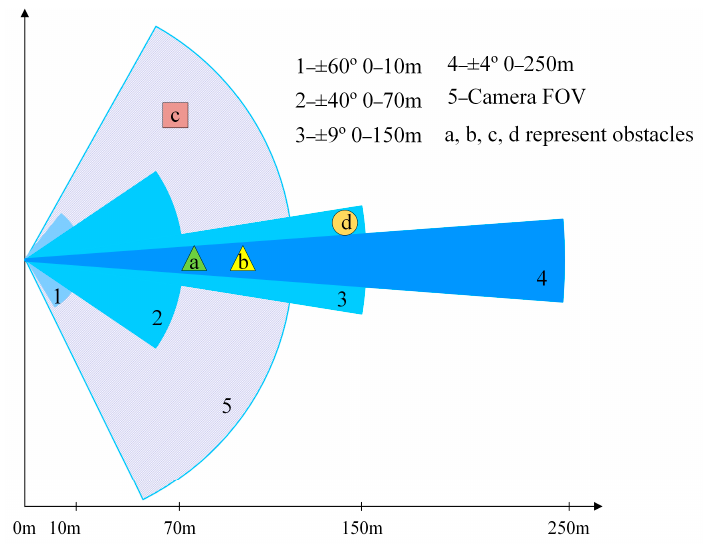
Figure 1. Visual field angle of fusion of single sensor and